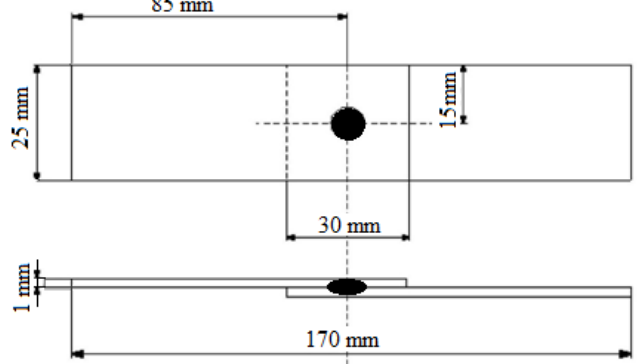
Figure 1. Geometry of the resistance spot-welded tensile shear test specimen.